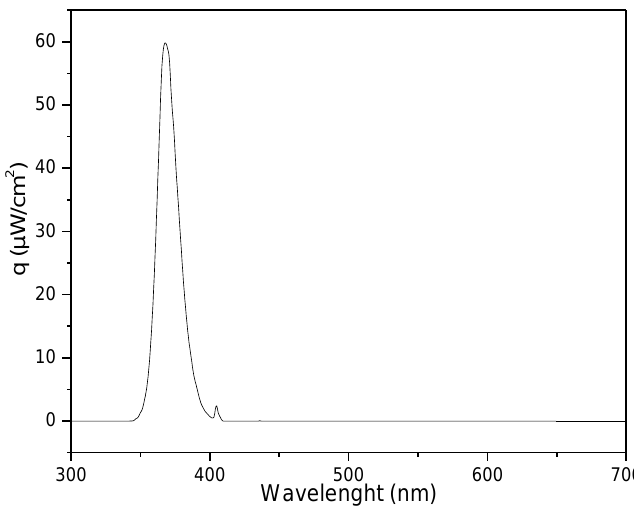
Figure A16. Near-UV Lamp Irradiation Spectrum . Figure A1. Near-UV Lamp Irradiation